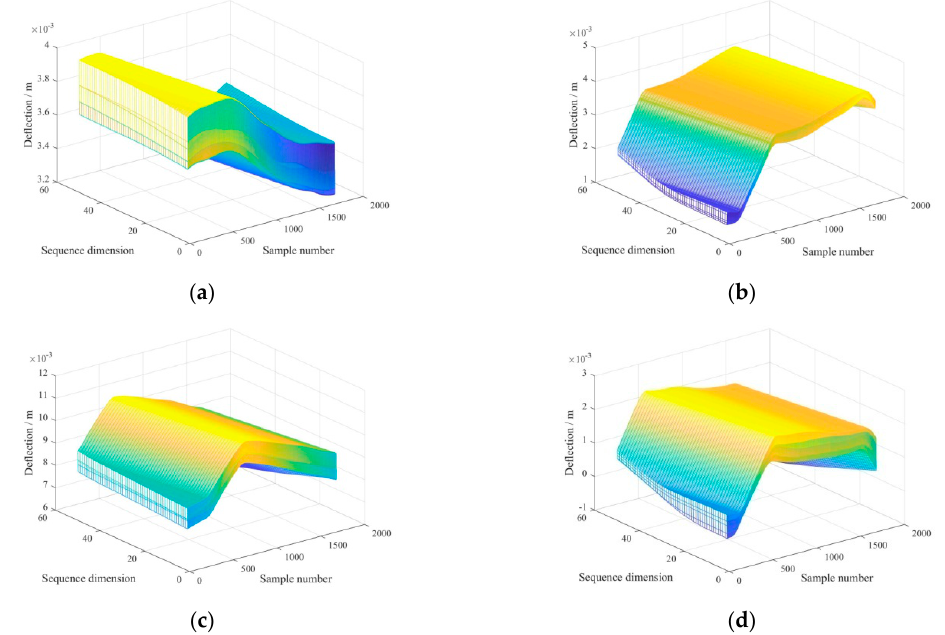
Figure 7. Sample set represented by mesh graphics through data augmentation for ( a ) intact, ( b ) damage 1/4 , ( c ) damage 1/2 , and ( d ) damage 3/4.